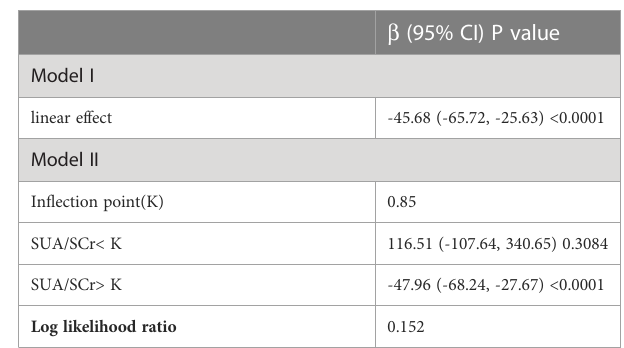
TABLE 5 Threshold effect analysis of between HDL-C on blood eosinophil counts in asthmatic adults using the two-piecewise linear regression model.